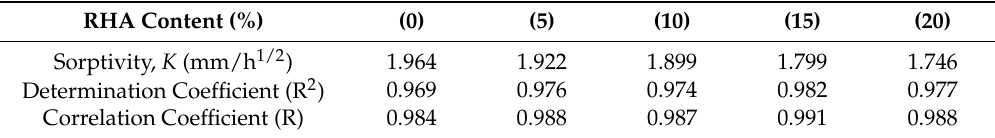
Table 10. Sorptivity by RHA inclusive concrete.